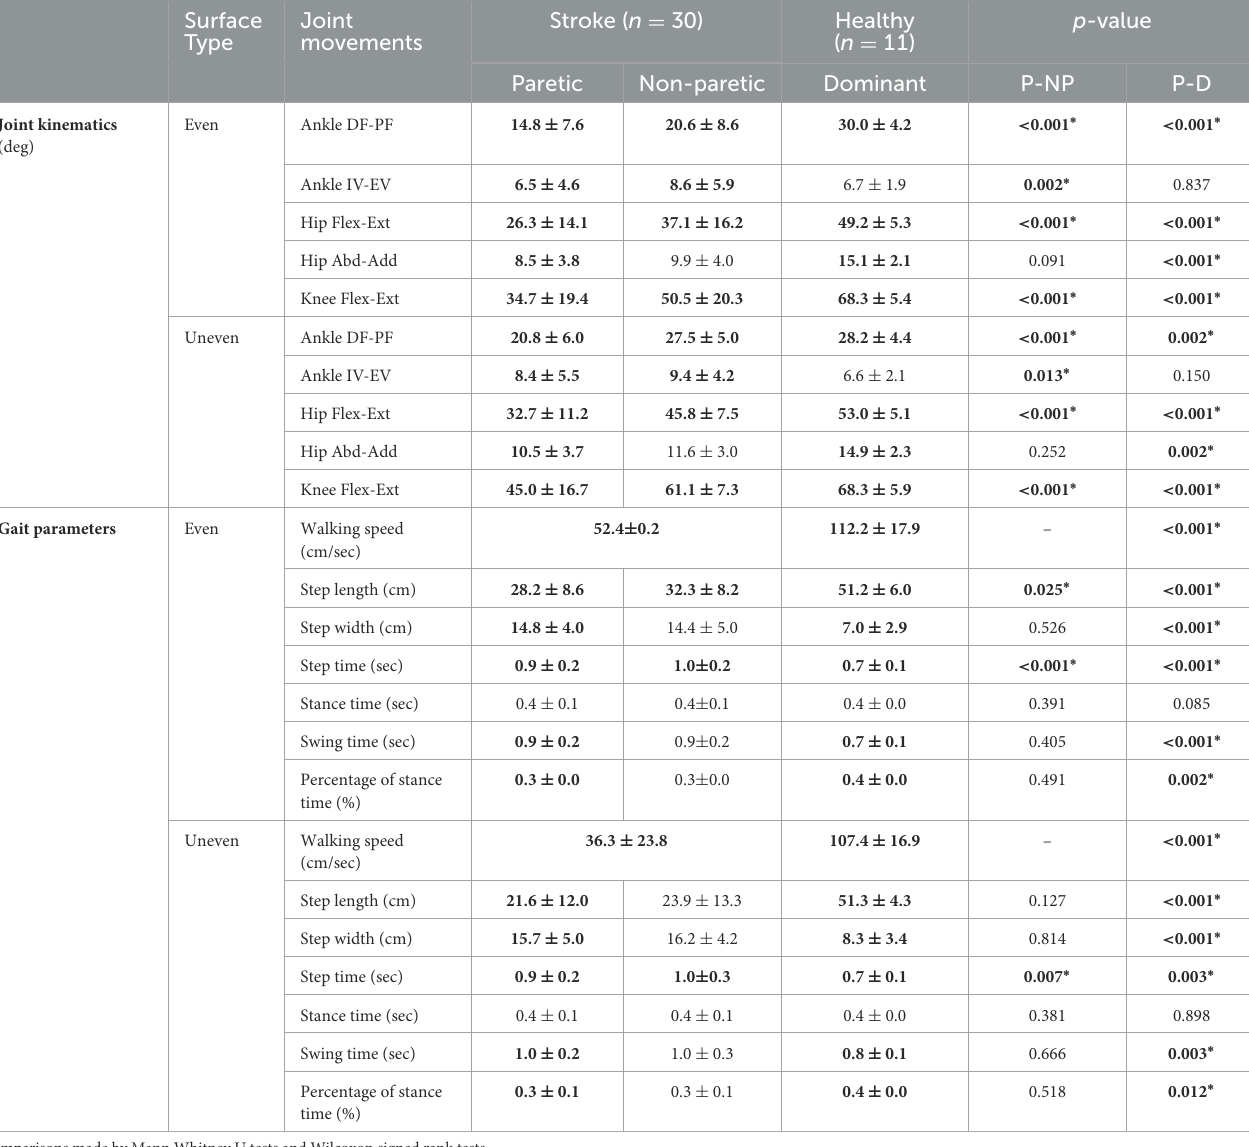
TABLE 2 Joint kinematics and gait parameters on even and uneven terrains between strokes and healthy